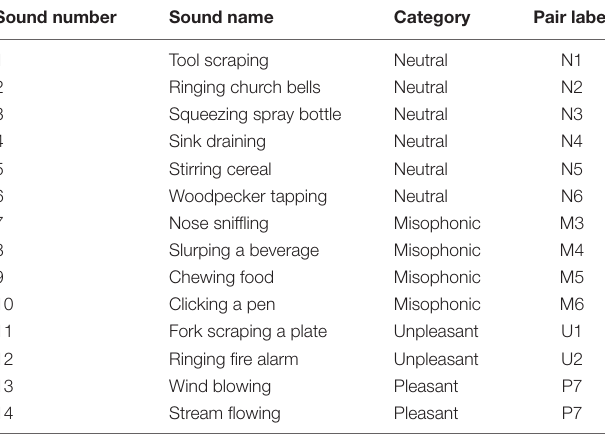
TABLE 1 | Fourteen sound stimuli utilized in Experiment 1 and Experiment